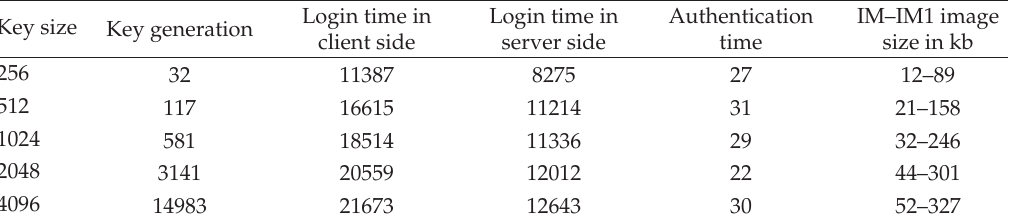
Table 1: Performance time for di ff erent key size.